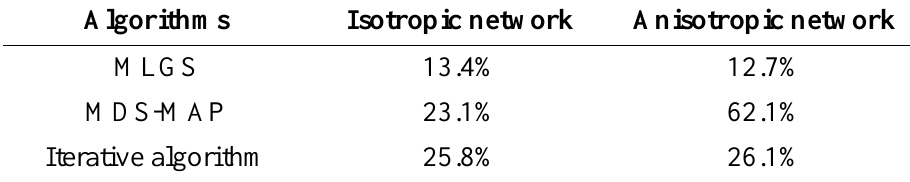
Table 2. Average errors of MLGS, MDS-MAP and iterative